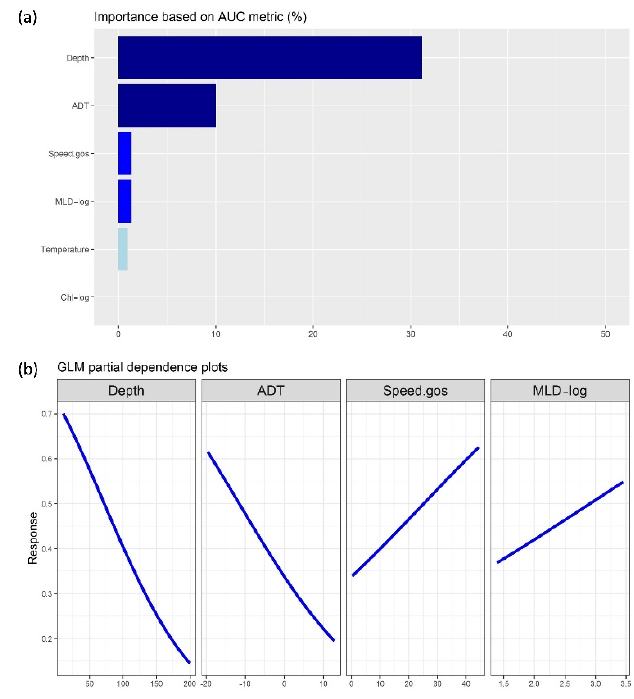
Figure 1. GLM results: ( a ), barplots of variable importance scores based on AUC-metric. The dark blue, blue and light blue colored bars indicate variables with high significance ( p -value < 0.01), moderate significance (0.01 ≤ p -value < 0.05) and no significance ( p -value ≥ 0.05), respectively. ( b ), partial plots of significant ( p < 0.05) parameters are shown.